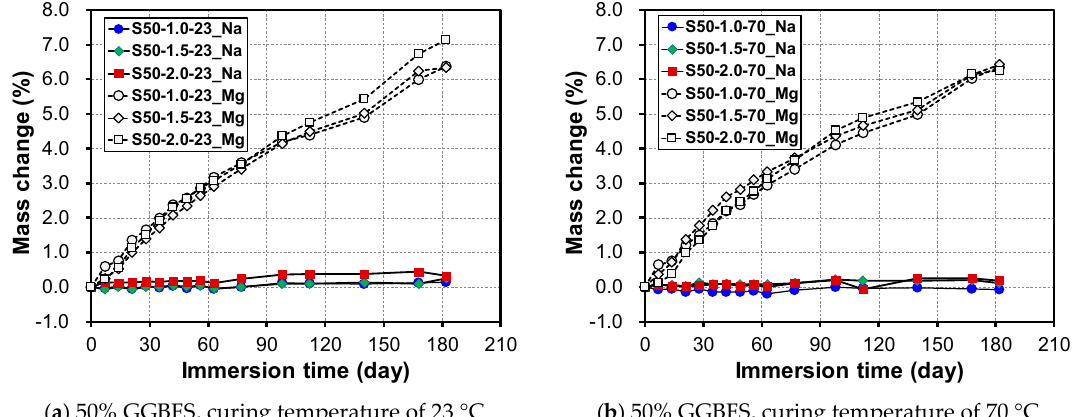
Figure 3. Change in mass by sulfate solution type, Ms, and initial curing temperature at ( a ) 23 °C and ( b ) 70 °C.